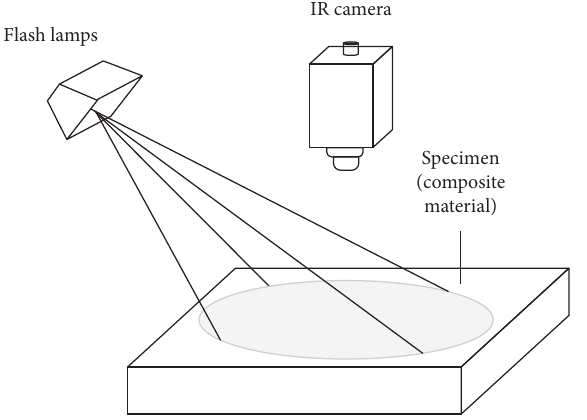
Figure 1: Thermal imaging data